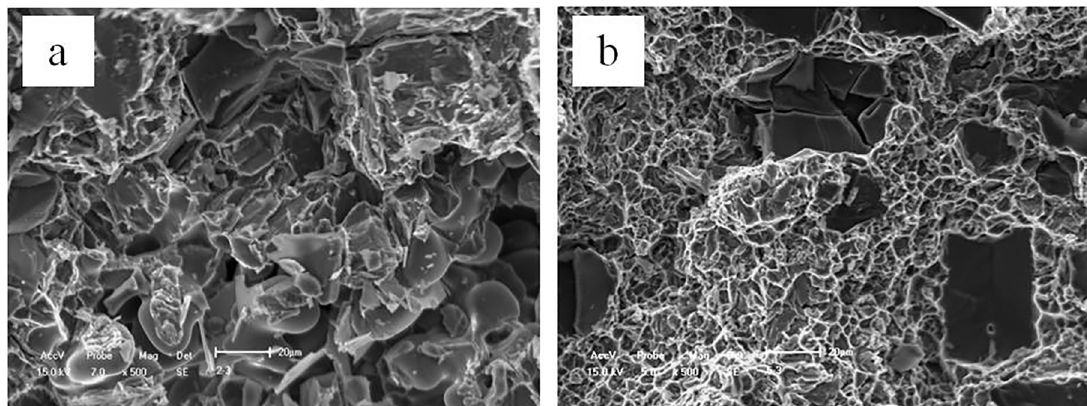
Figure 5. The SEM images of fracture surfaces of (a) as-cast A390-0.3Nd alloy sample; and (b)extruded and heat treated sample of A390-0.3wt%Nd